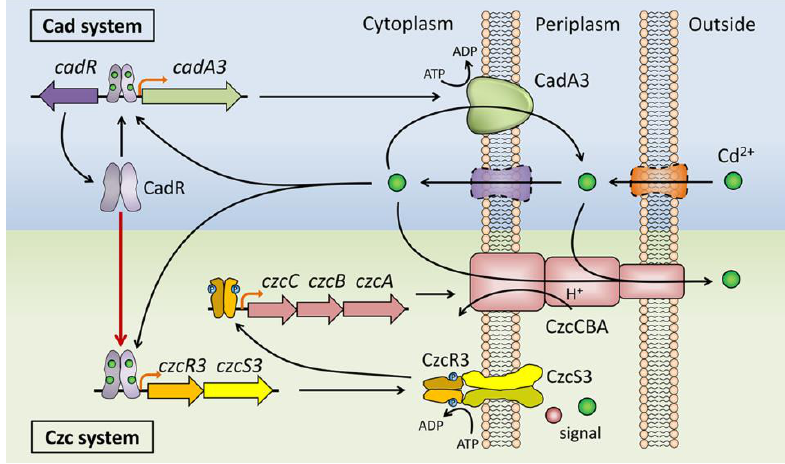
Figure 7. Cooperation between Czc and Cad systems confers P. putida the resistance to cadmium. Supplementary Materials: The following are available online at www.mdpi.com/xxx/s1.